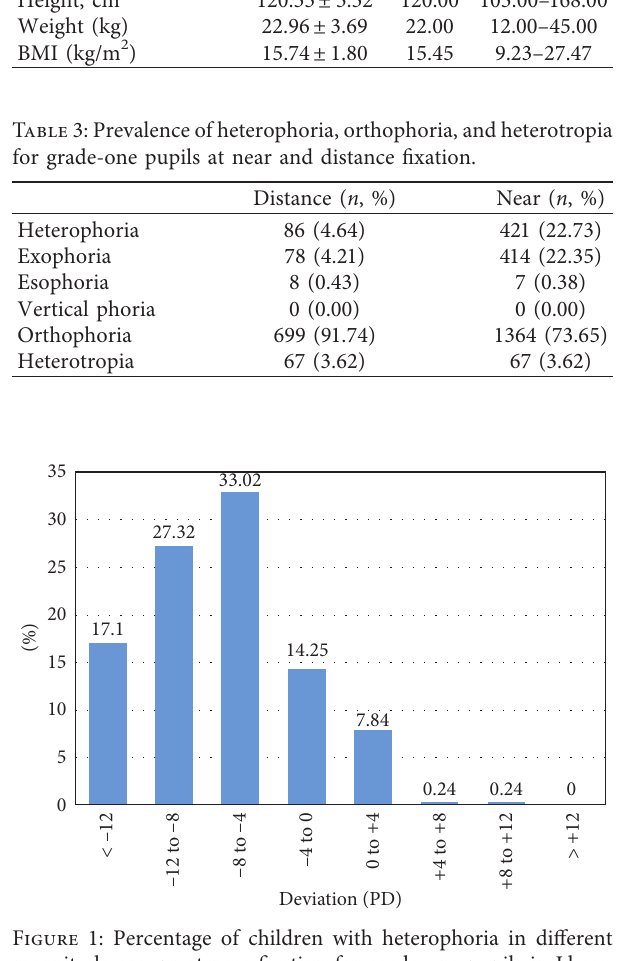
Figure 1: Percentage of children with heterophoria in different magnitude groups at near fixation for grade-one pupils in Lhasa, Tibet Autonomous Region, China ( n �